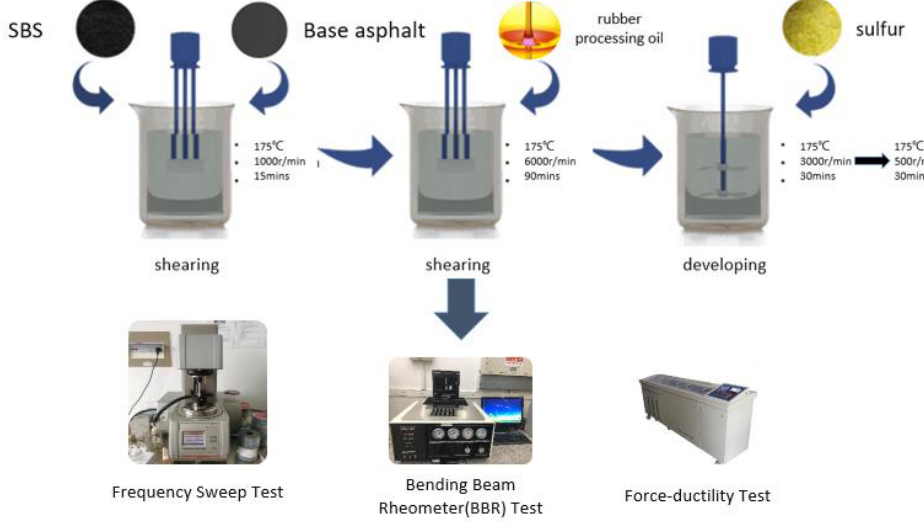
Figure 1. The flow chart of the research.